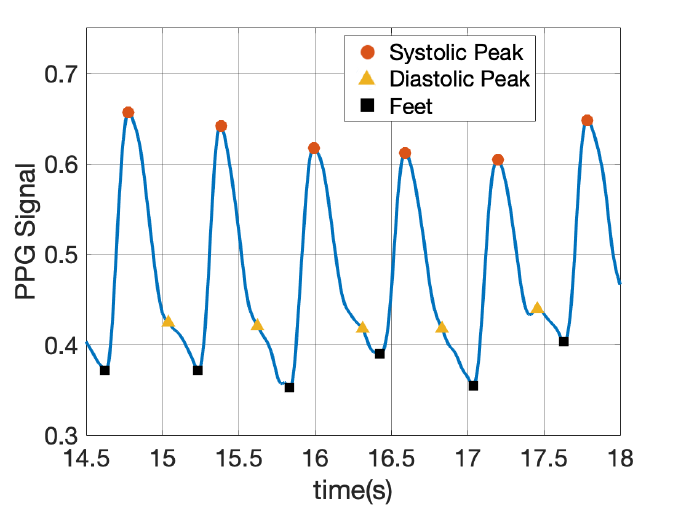
Figure 2. PPG waveform displaying poorly visible dicrotic notch and diastolic point. The extracted sys- tolic points, diastolic points, and waveform feet are shown as circles, triangles, and squares,